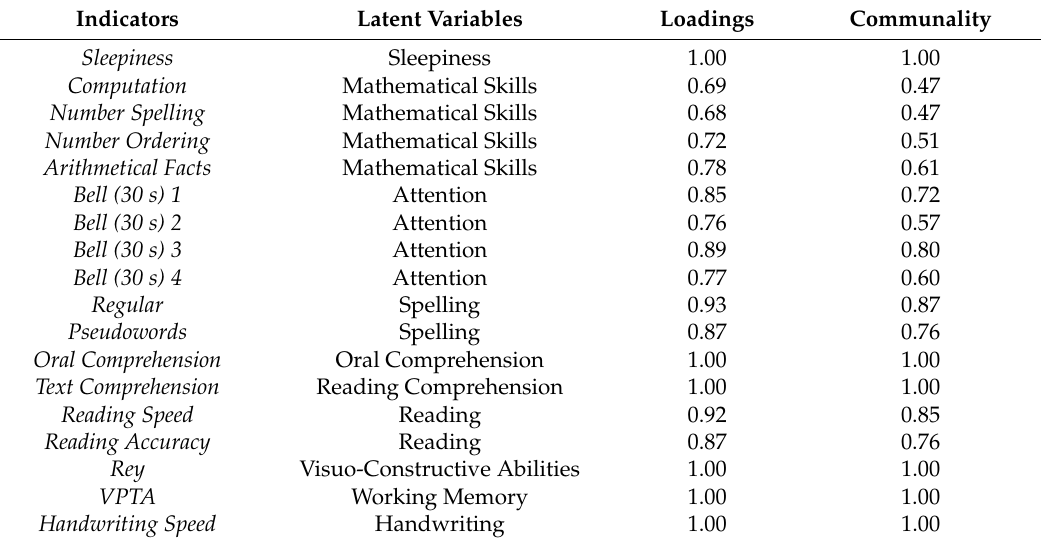
Table 3. Outer model with loadings and